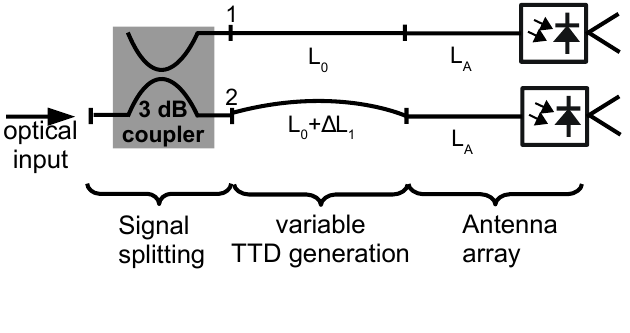
Figure 3. Photonic beamforming network for 2 × 1 antenna array ( ∆ L experimental setup).